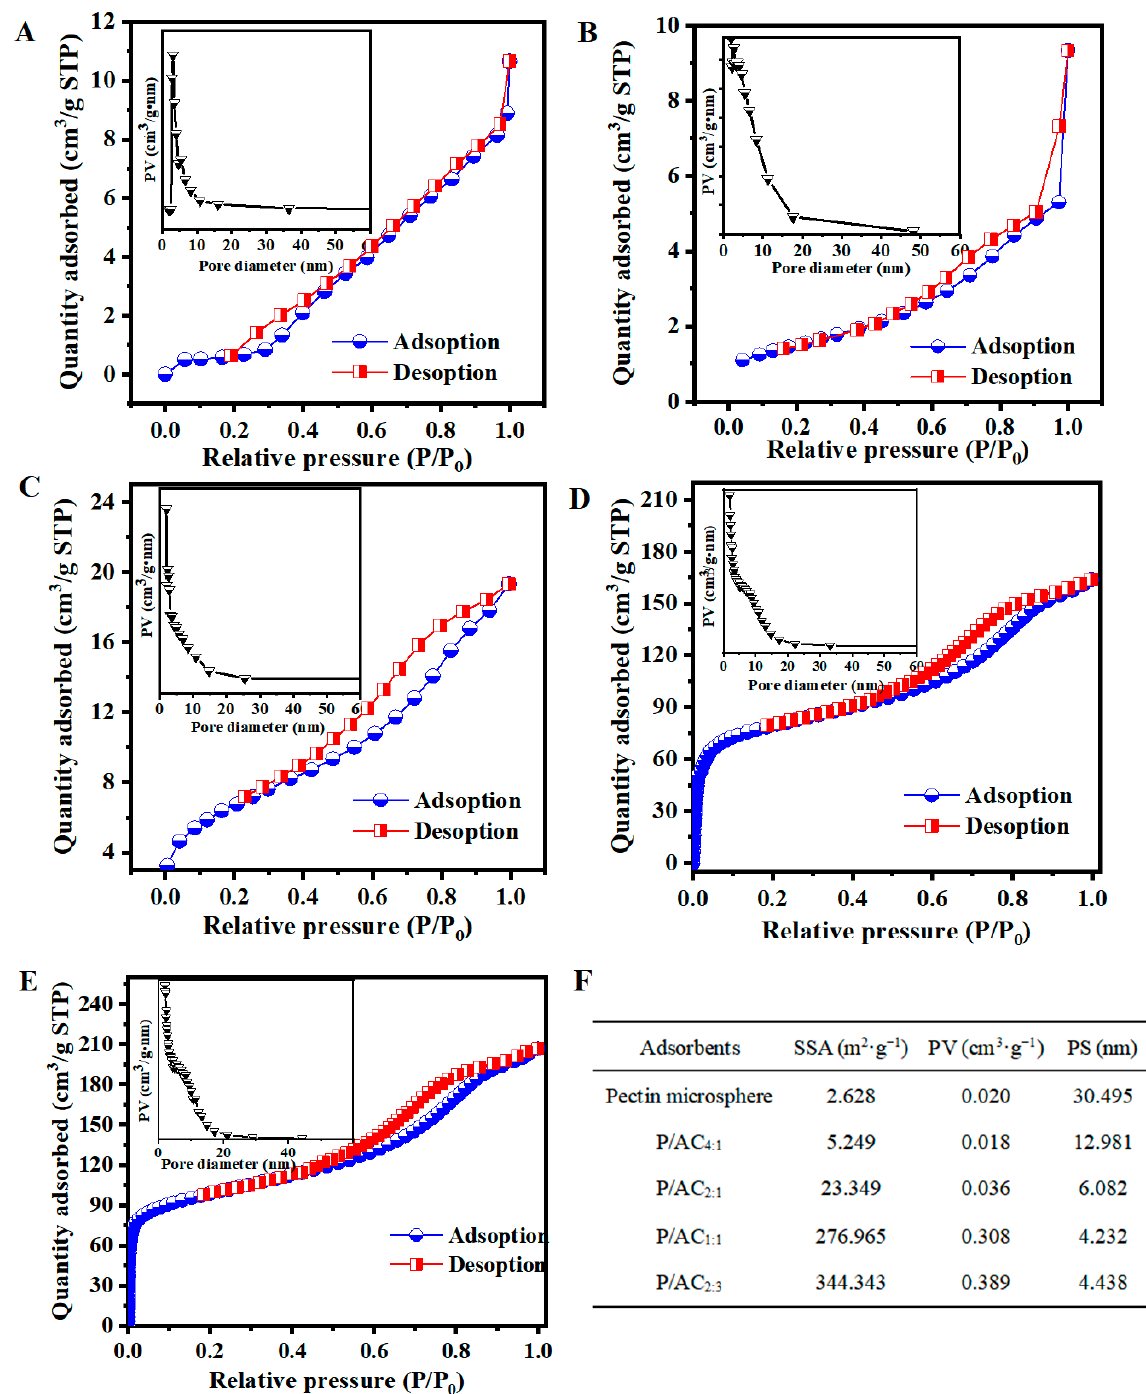
Figure 3. Nitrogen adsorption/desorption isotherms of ( A ) pectin microsphere, ( B ) P/AC 4:1 , ( C ) P/AC 2:1 , ( D ) P/AC 1:1 , and ( E ) P/AC 2:3 (Inset: Pore-volume distribution). ( F ) the specific surface area (SSA), average pore size (PS), and pore volume (PV) of pectin microsphere and P/ACs.